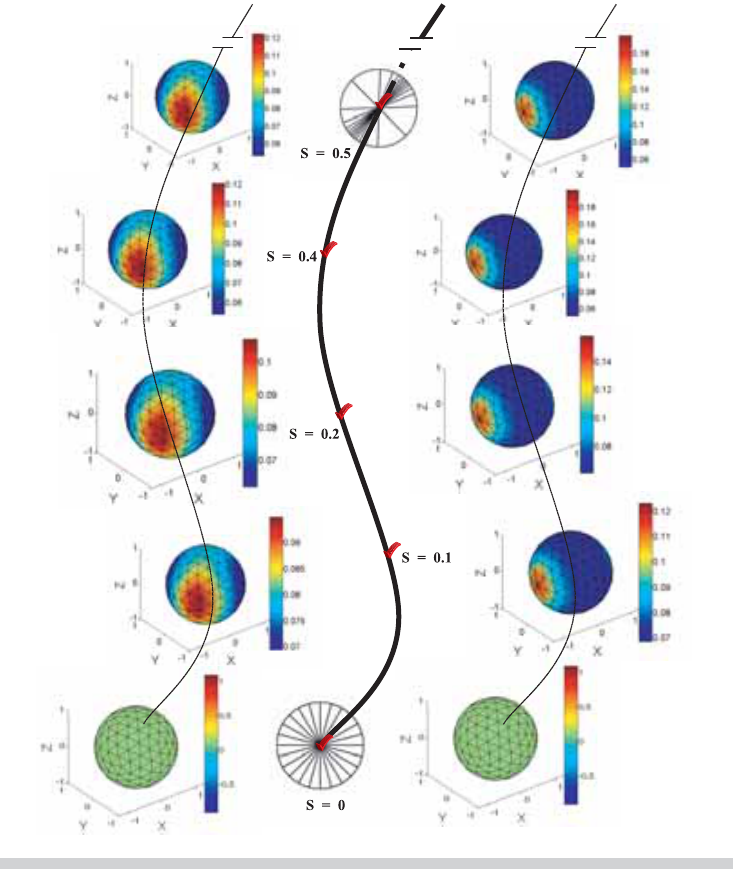
Figure 1 (left): Evolution of the steady dis- tribution function defined on the unit surface along the chain arc-length for D = 1 and We = 1: Shear s flow (left) and longational flow (right). Figure 2: Approximation functions: (top-left) most significant approximation function, (top-right) second most sig- nificant function, (bottom- left) third most significant function, and (bottom- right) fourth most signifi- cant approximation func-